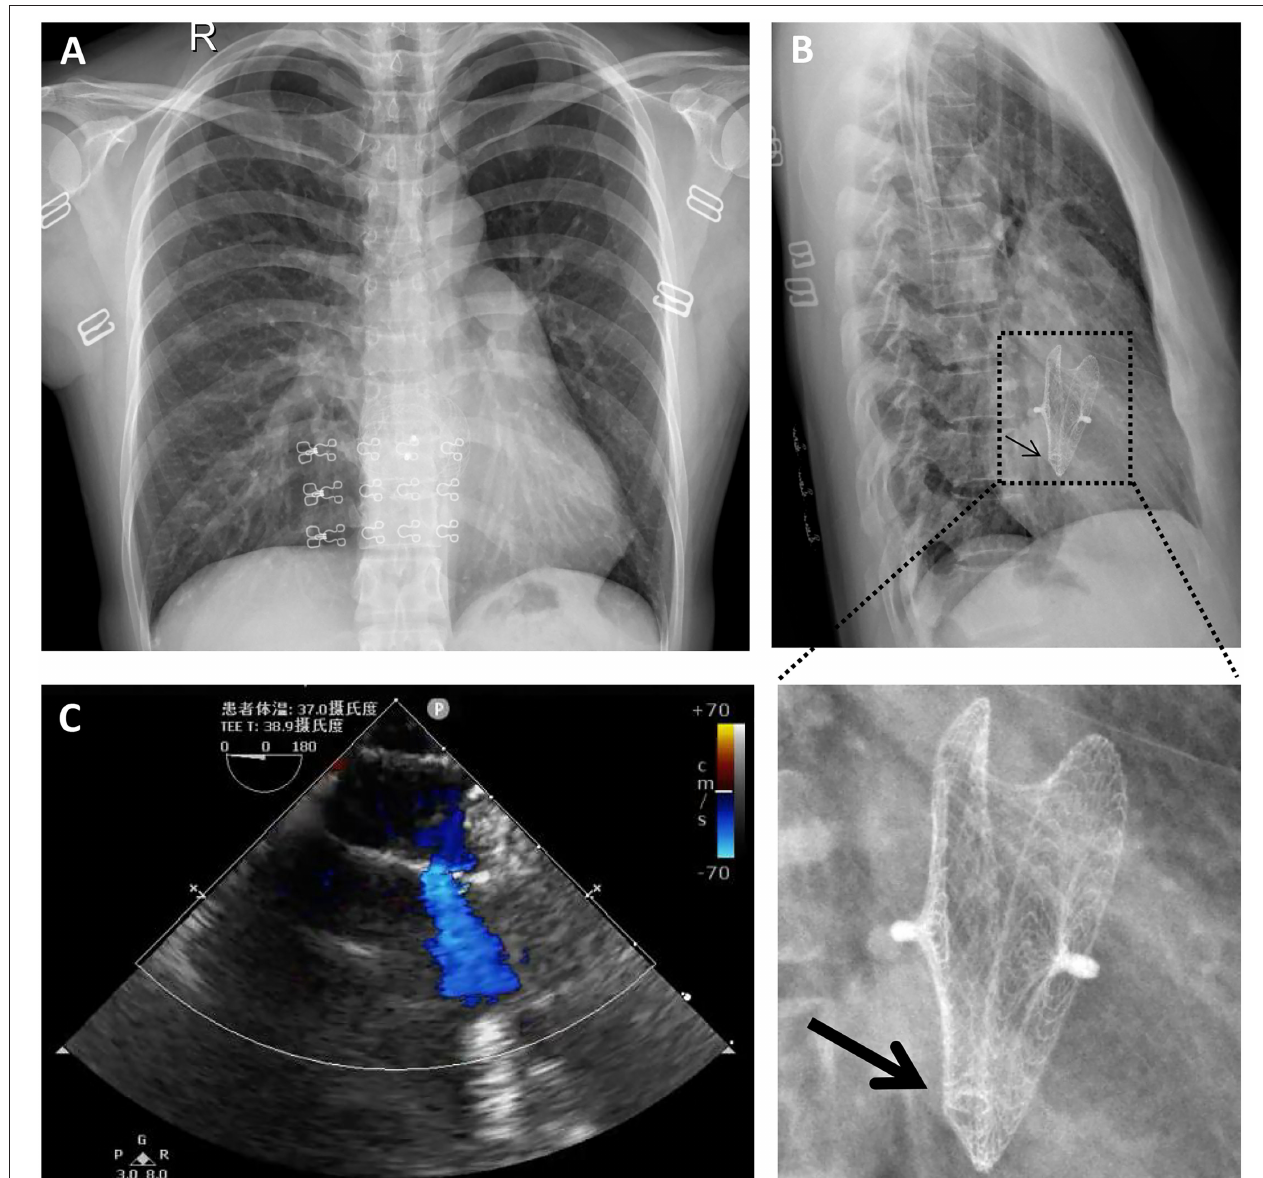
FIGURE 1 | Chest radiography (A,B) and transthoracic echocardiography (C) preoperatively indicated that most parts of the closure were deformed, especially the left atrial side [ (B) , arrow]; a significant multi-bundle left-to-right shunt through the device and a small adhesion on the occluder was detected (C)